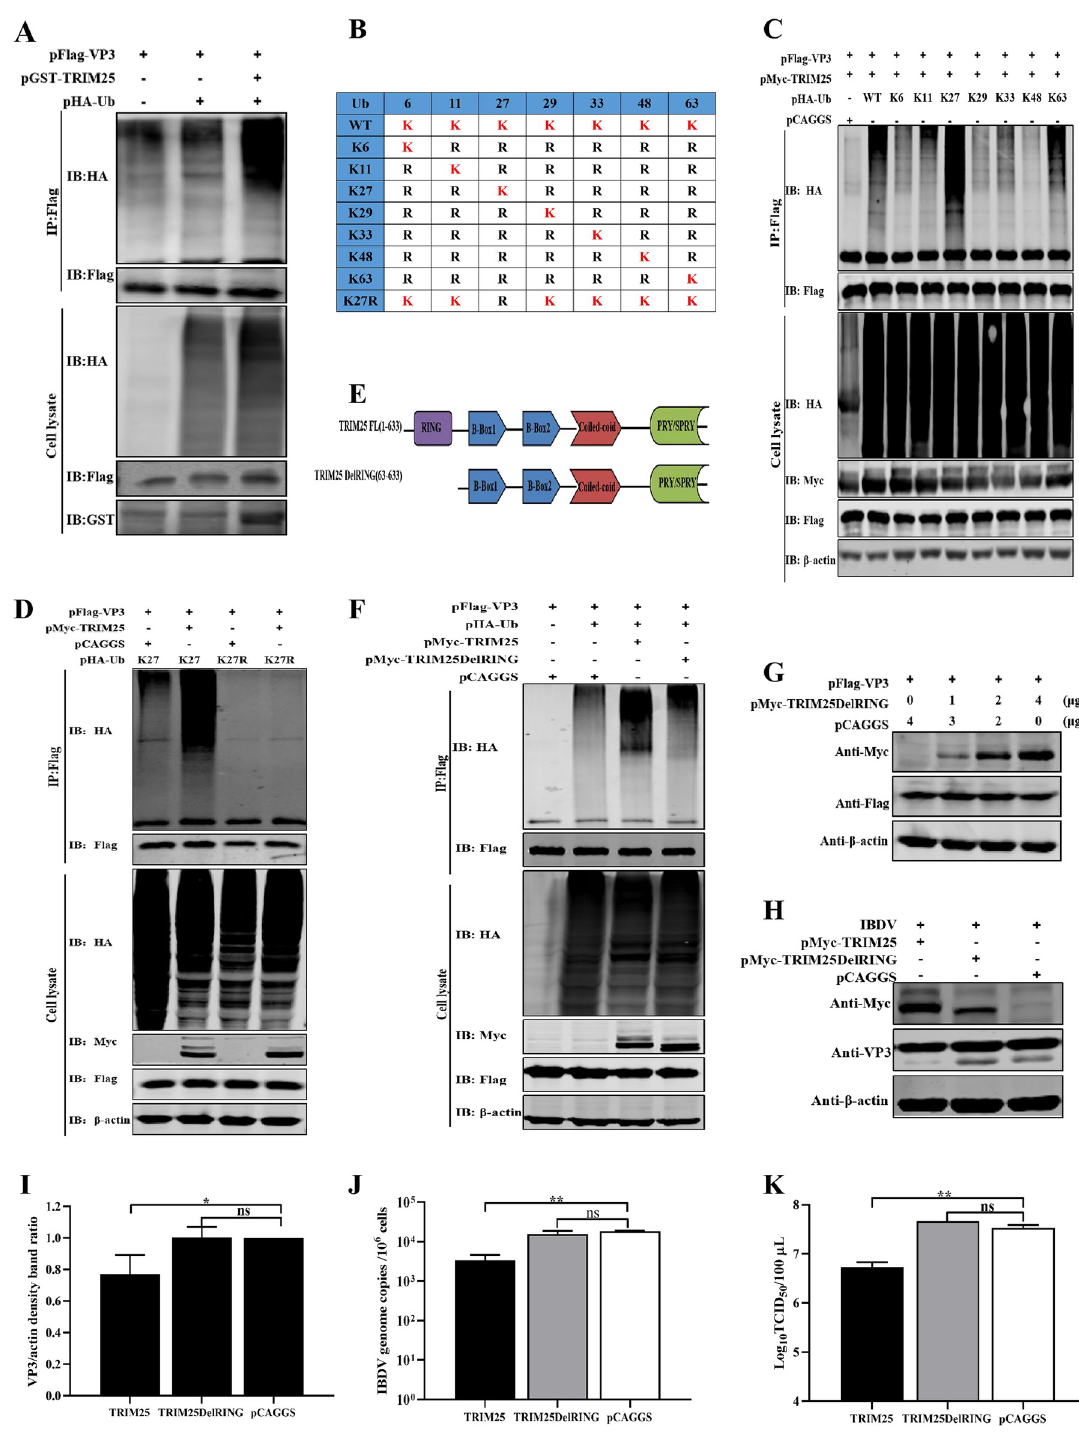
Fig 6. TRIM25 induces the ubiquitination of VP3. (A) TRIM25 promoted the ubiquitination of VP3. The pFlag-VP3 and pHA-Ub plasmids were co-transfected with or without pMycTRIM25 into HEK293T cells for 36 h. The lysate were incubated with indicated anti- Flag mAb and detected using an IP assay. (B) Schematic representation of the constructing strategy of eight Ub mutants (K6, K11, K27, K29, K33, K48, K63, and K27R). (C and D) TRIM25 catalyzed the K27-linked polyubiquitination of VP3. pFlag-VP3 and different pHA-Ub plasmids were co-transfected with pMyc-TRIM25 into HEK293T cells for 36h. Then, lysates were incubated with indicated anti-Flag mAb and detected using IP. (E) Schematic representation of the structure of TRIM25 and TRIM25DelRING. (F)